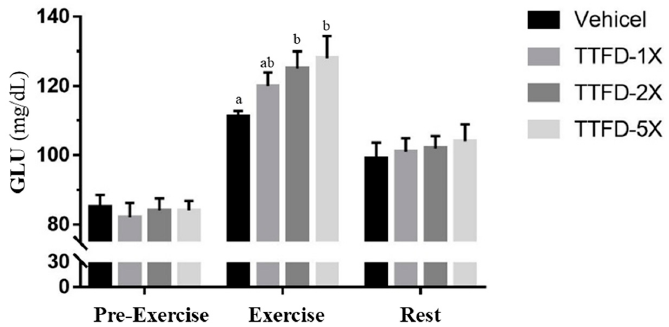
Figure 6. Effect of 4-week TTFD supplementation on the serum GLU levels profile during exercise. The indicated four groups collected three time points including beginning, 10 min acute exercise and 20 min rest. Data are mean ± SEM for n = 10 mice per group and the columns with different letters (a, b) are significantly different at P < 0.05.